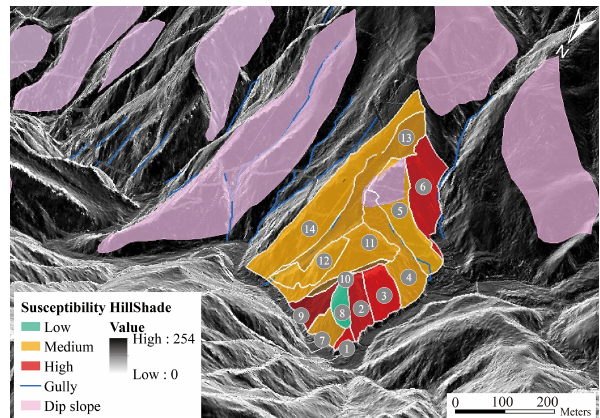
Figure 6. Susceptibility level referring to slope units around the Neikuihui tribe (background: modified from 2020 data from the De- partment of Lands, Ministry of the Interior, for research purposes only; aerial: ESRI ArcGIS